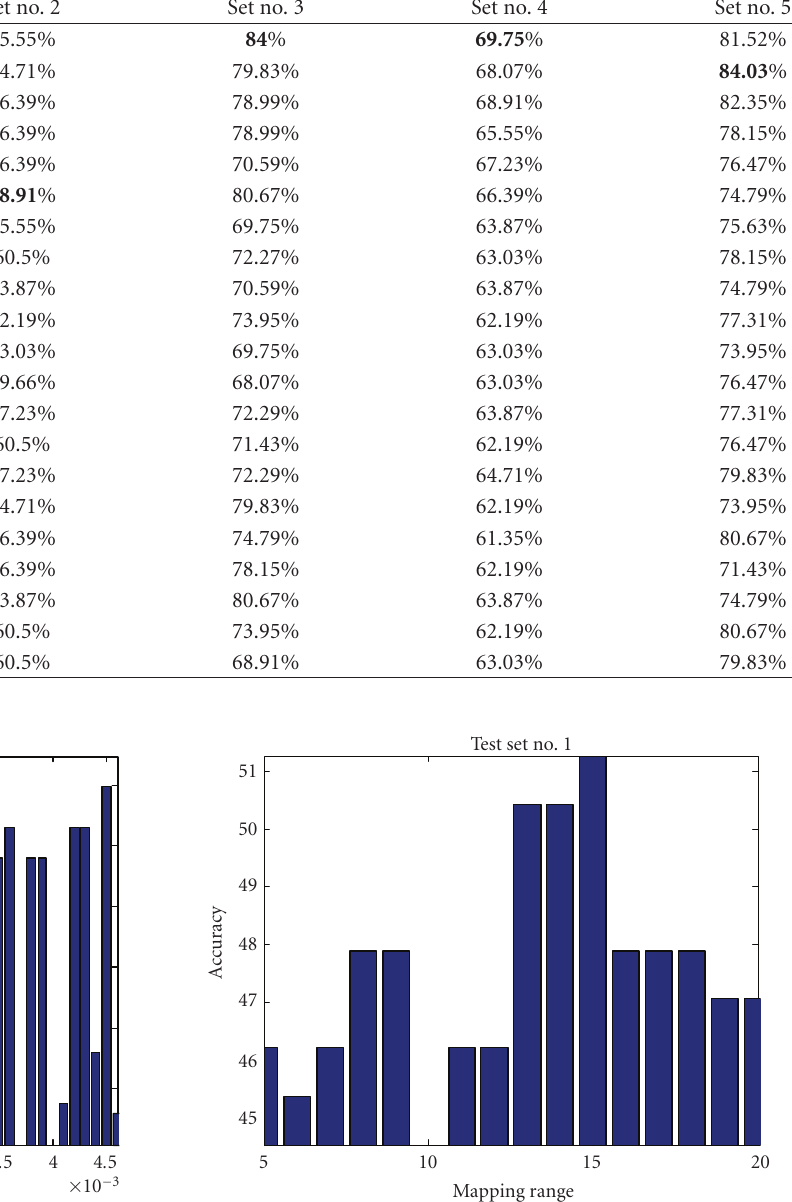
Figure 8: Learning rate impact on algorithm accuracy for test set no. 5 where other parameters are kept constant.